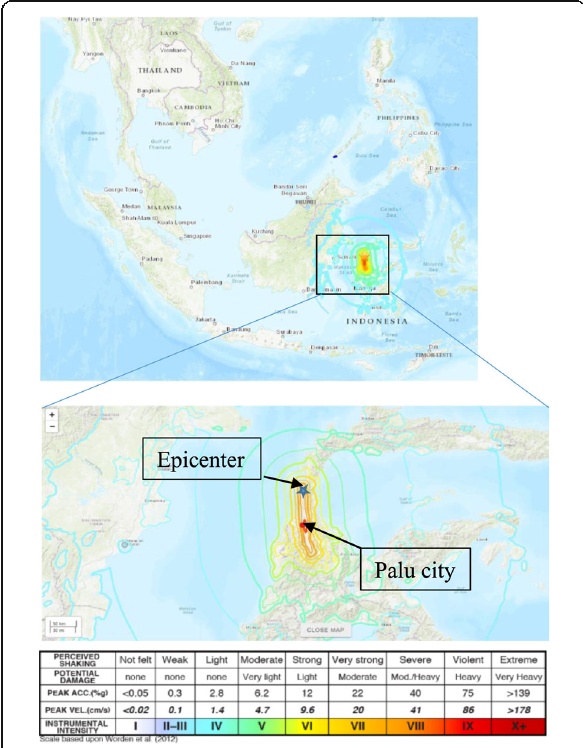
Fig. 1 Intensity distribution map with location of the epicenter